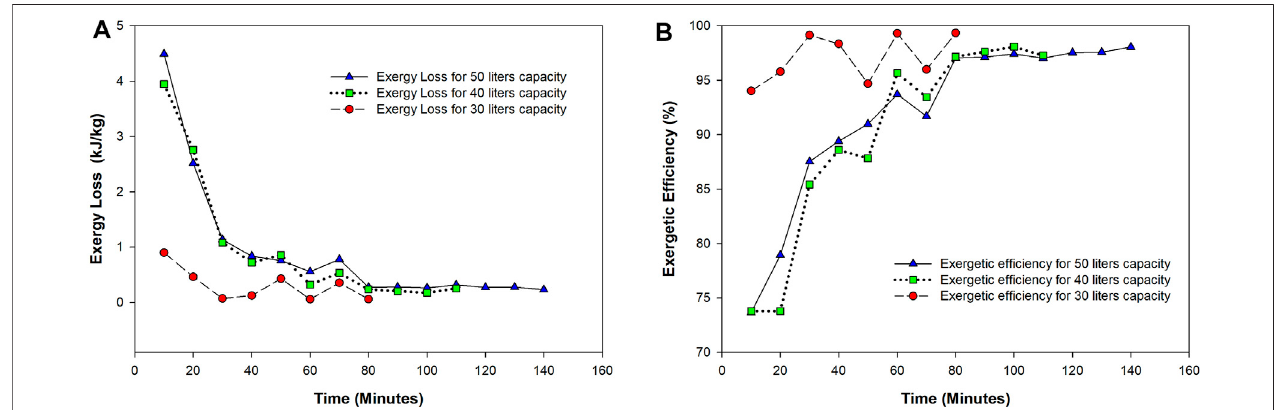
FIGURE 4 | Exergy losses (A) and exergy ef fi ciencies (B) during heating processing of 50, 40, and 30 L raw milk.